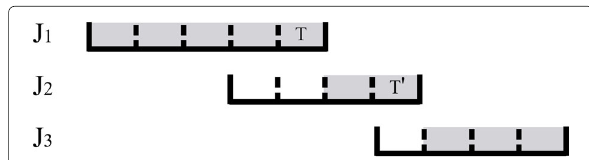
Fig. 3 An example for link and reaching Fig. 4 An example for